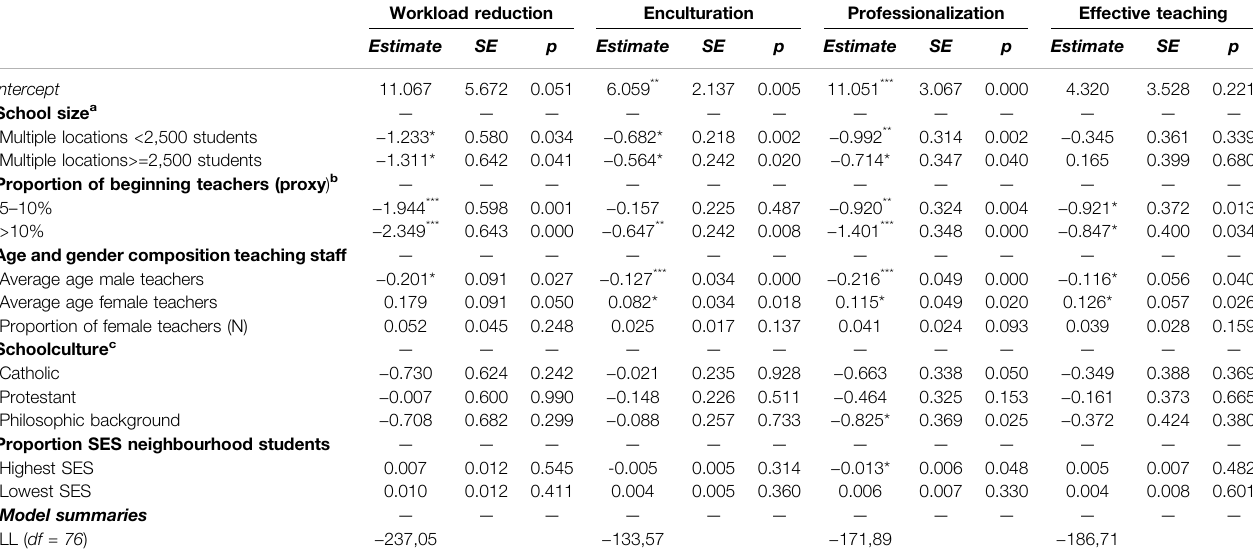
TABLE 5 | Linear regression models: reported support activities by BTs and school characteristics, four induction elements, non-PDSs (N (cid:1)